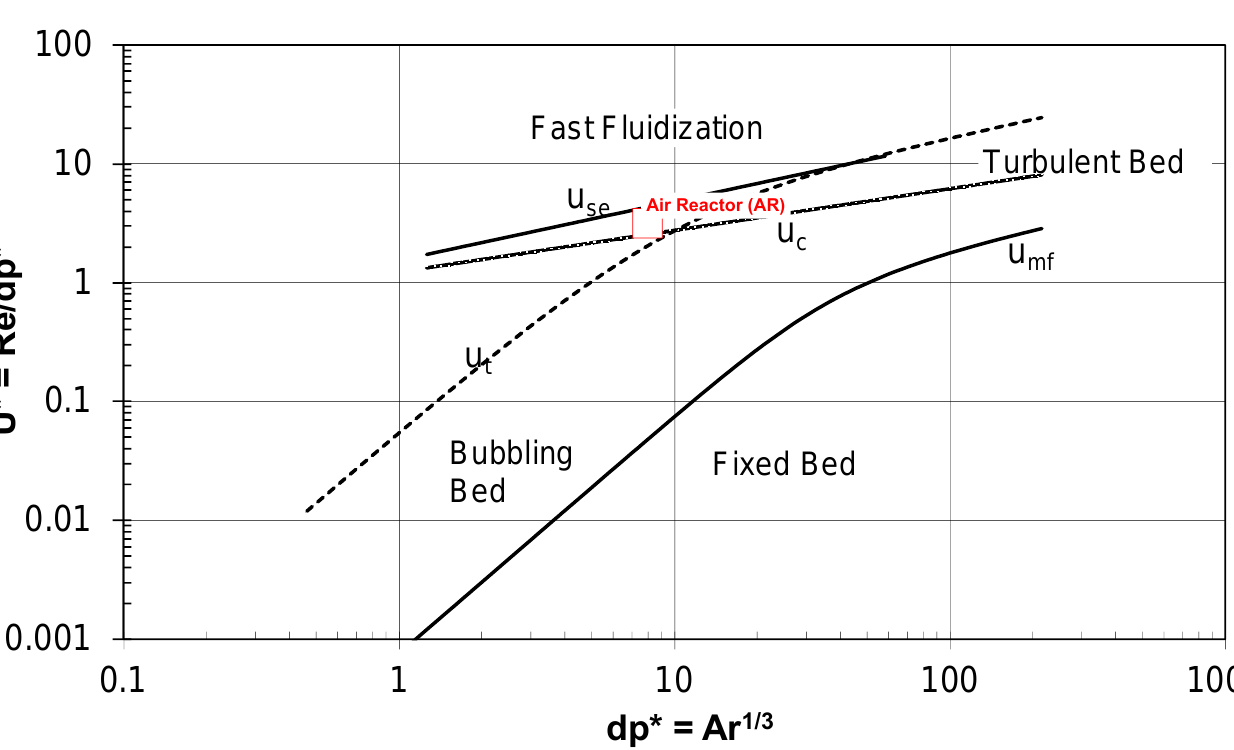
Figure 8. Pressure trend in the circulating riser. Modified from [67, 68]